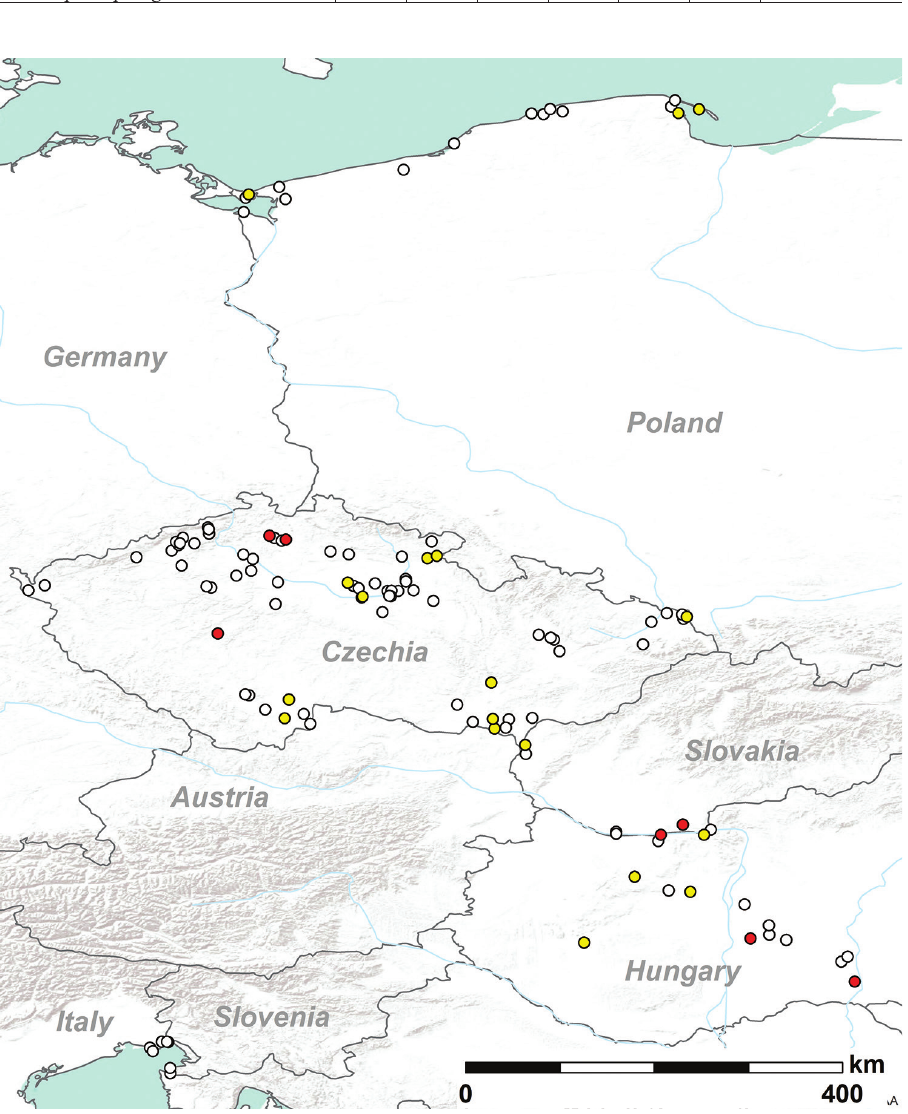
Figure 1. Map with occurrence of Gasteruption assectator (yellow) and Gasteruption nigrescens (red) in the localities studied. Empty circles represent the localities where these species have not been